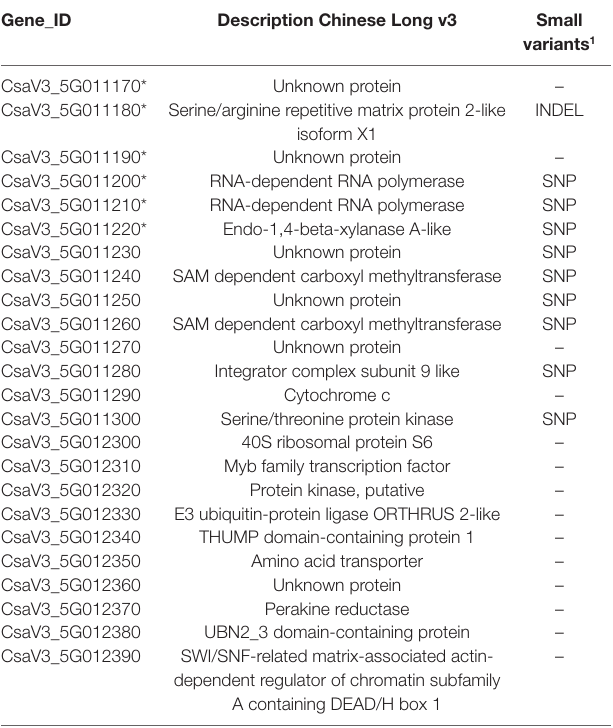
TABLe 2 | List of genes within the interval of CsCVY-1 locus in the Chinese Long 9930 v3 cucumber genome annotation, variants and structural variation analysis between P S and P R